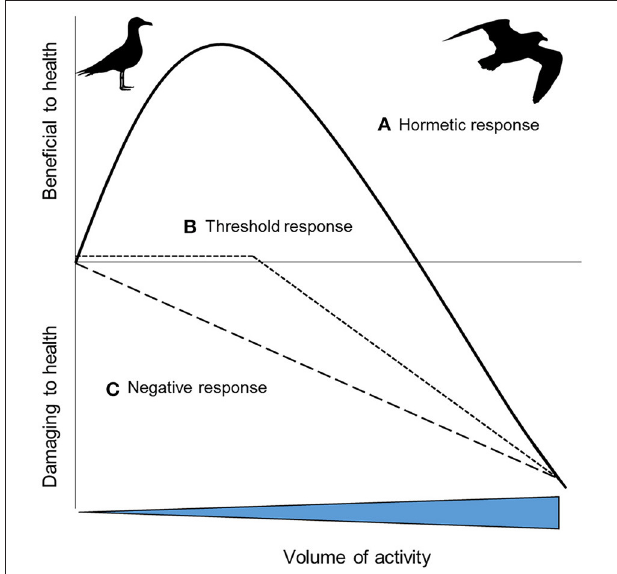
FIGURE 1 | Hypothetical health outcomes as a result of increasing volumes of activity: (A) a hormetic response where increasing activity provides initial health benefits, before then having an increasingly negative impact; (B) increasing activity has no or little impact on health up to a threshold, after which it becomes progressively more deleterious; (C) the impacts on health of increasing activity are progressively more deleterious [inspired by 43].